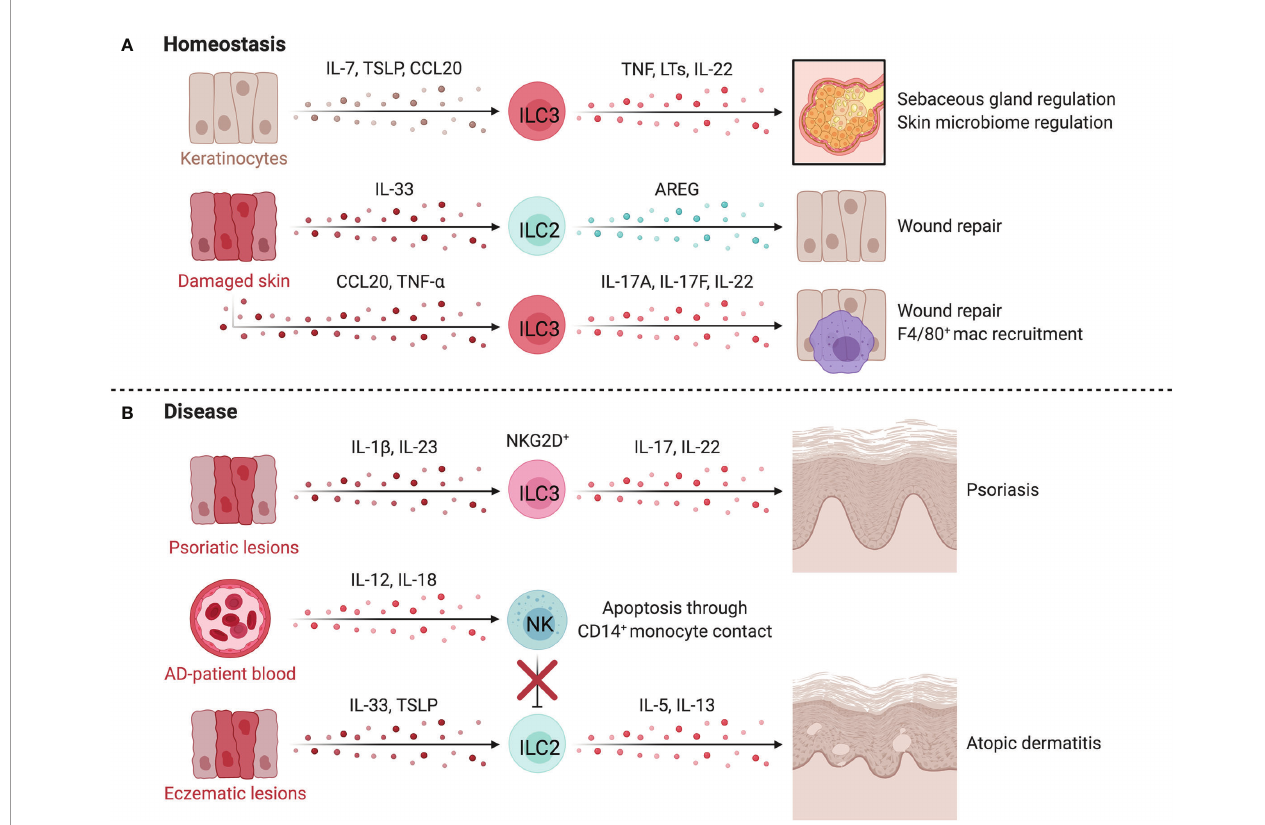
FIGURE 5 | ILCs in the skin. At homeostasis (A) , ILCs are retained by IL-7 and TSLP released by hair follicle keratinocytes or epithelial skin cells. TNF- a + LT a 1 b 2 + CCR6 + ILC3s negatively regulate lipid-secreting sebaceous glands, regulating the skin microbiome, which can alter susceptibility to in fl ammatory conditions or affect tissue repair pathways. Upon tissue damage, injured epithelial cells release IL-33, inducing proliferation of skin-resident ILC2s. In mice, anti-CD90 depletion in Rag1 -/- mice delays wound healing, suggesting a role for ILC2s in promoting epithelial repair via AREG. The epithelium also produces TNF- a downstream of damage-induced Notch signaling in keratinocytes, recruiting CD4 + NKp46 low/- ILC3s that participate in wound closure. TNF- a driven release of CCL20 and CXCL13 by keratinocytes recruit ILC3s which facilitates the recruitment of F4/80 + reparative macrophages. In disease (B) , psoriatic lesions in mice accumulate IL-17 + IL-22 + NCR + ILC3s which is mirrored by the increase of CD56 + ROR g t + ILC3s in both in fl amed and non-in fl amed skin of psoriasis patients. ILC2s promote atopic dermatitis (AD) when activated by epithelial-derived TSLP and IL-33 in in fl ammatory lesions. Dermal NK cells are decreased in AD and prone to apoptosis through contact with CD14 + monocytes. NK cells are proposed to regulate ILC2 abundance in AD, as therapeutic expansion of NK cells lowers ILC2 counts and improves disease scores in an AD mouse model. Created with